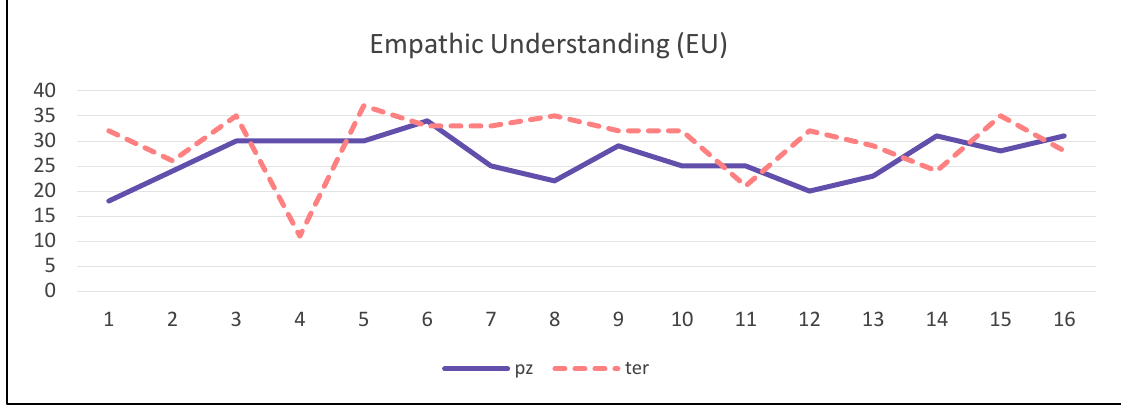
Figure 1: Trend of Empathic Understanding (EU) Subscale (Barrett-Lennard, 1986)